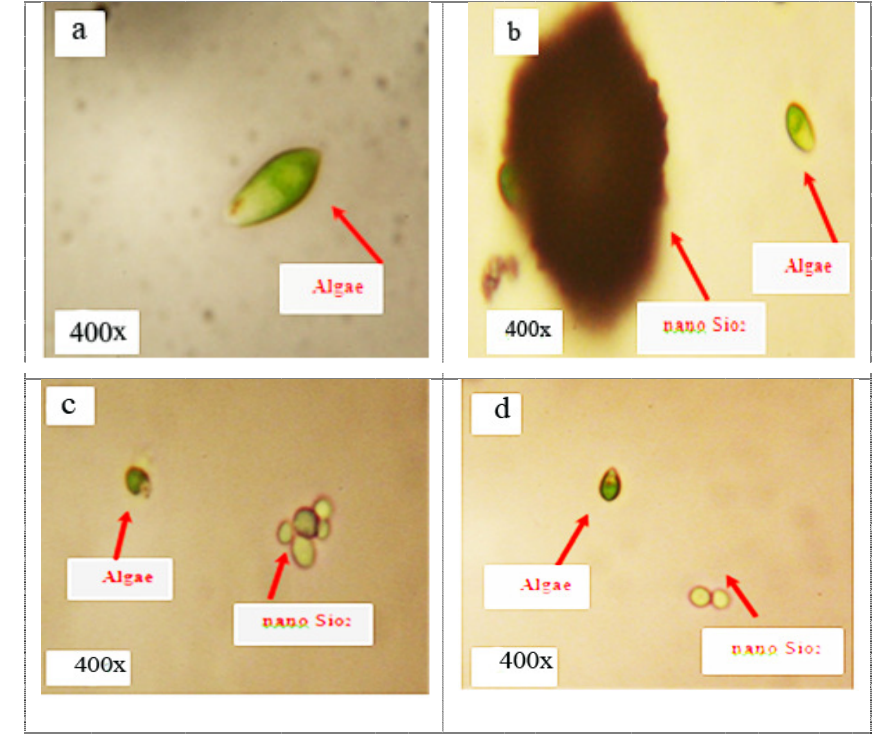
Fig. 6. a,b: Dunaliella salina before contact with SiO 2 NPs; c and d: accumulation of NPs on Dunaliella salina after 72 hours contact with SiO 2